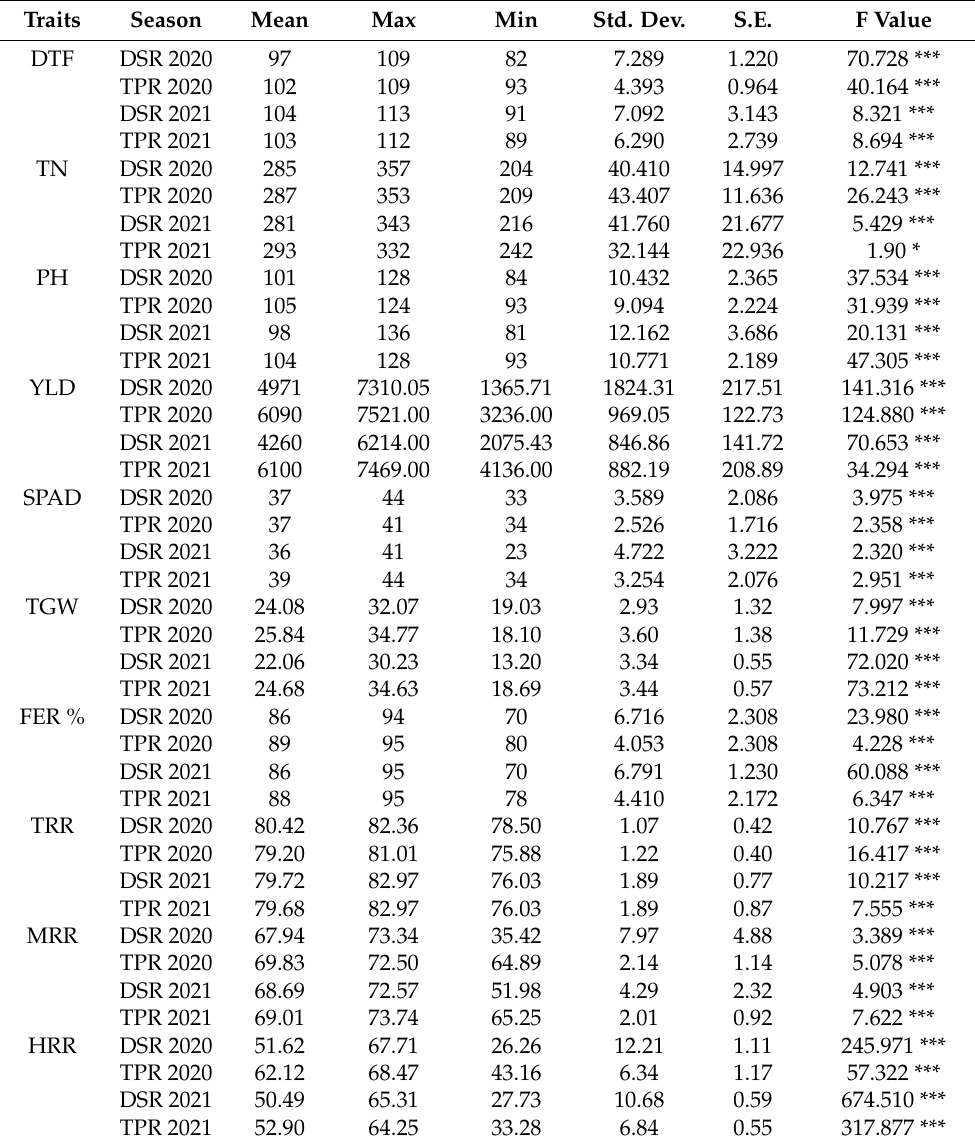
Table 3. Mean value of plant morpho-physiological and grain quality traits across different seasons under direct seeded and transplanted puddled system of rice cultivation. Traits Season Mean Max Min